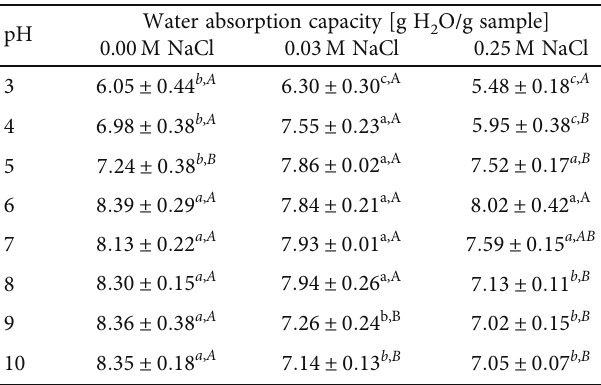
Table 5: Water absorption capacity of deproteinized ethanol- treated sun fl ower meal at di ff erent pH and NaCl concentrations.